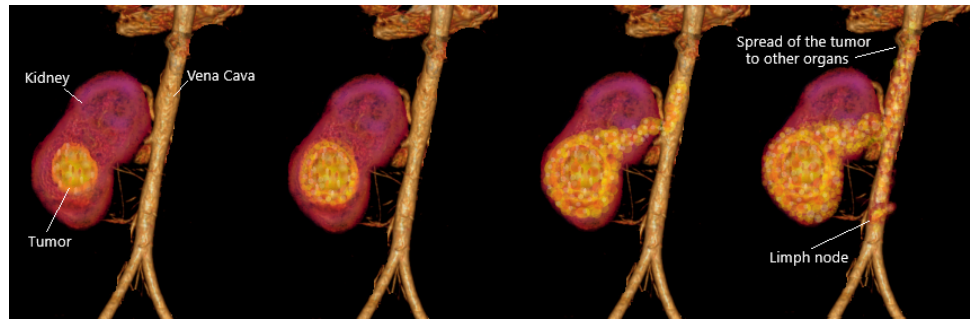
Figure 3. Illustration of kidney tumor